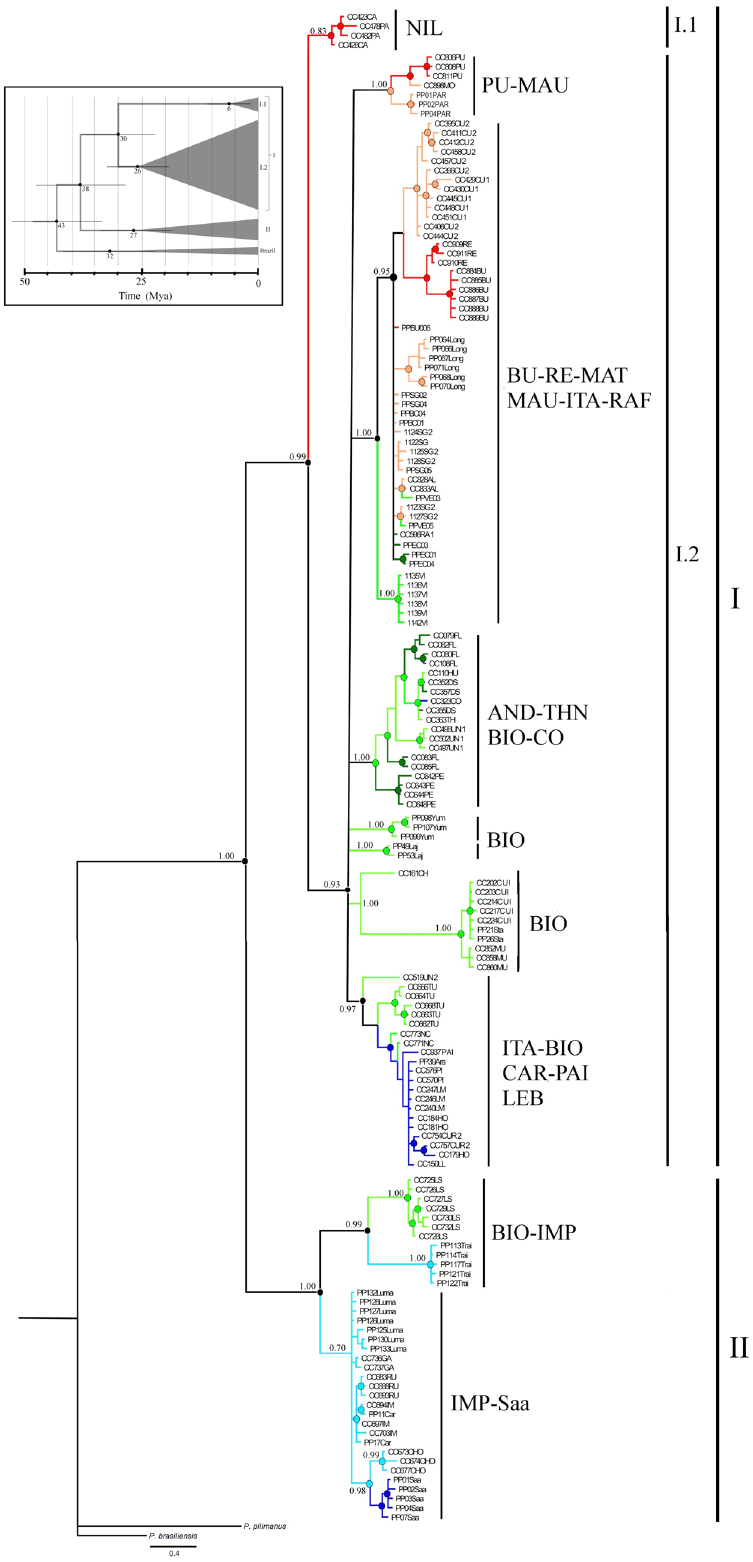
Figure 2. Genealogical relationships of COI haplotype s of Parastacus pugnax as inferred by Bayesian analysis. Colors correspond to those depicted in Fig. 1. Bayesian a posteriori probabilities (PP) values are given only for the main clades; circles on nodes indicate PP values equal or higher than 0.8. Acronyms correspond to basins as described in Table 1. The box at the top indicates the divergence times (in million years) for the main